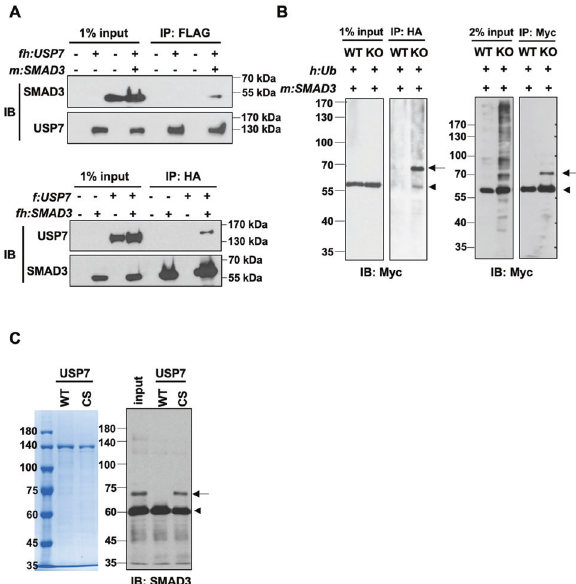
Fig. 6 USP7 interacts with SMAD3 and deubiquitinates the mono- ubiquitinated SMAD3. A Co-immunoprecipitation (co-IP) assays with anti-Flag (upper) or anti-HA (bottom) resins showing the interactions between USP7 and SMAD3 in HEK293T cells transfected with indicated expression constructs. fh Flag-HA, m Myc, f Flag. B Immunoprecipitation (IP) assays showing SMAD3 is mono- ubiquitinated in the absence of USP7. HEK293 wildtype (WT) or USP7 KO (KO) cells were co-transfected with expression vectors for HA-tagged ubiquitin (h:Ub) and Myc-tagged SMAD3 (m:SMAD3). IPs were performed with anti-Myc and anti-HA antibodies followed by immunoblotting with anti-Myc antibody. Arrow and arrowhead indicate mono-ubiquitinated and unmodi fi ed SMAD3, respectively. C Immunoblots of SMAD3 (right) in the reaction product of in vitro deubiquitinating assays showing the removal of mono-ubiquitin from SMAD3 by recombinant USP7 wildtype (WT) but not deubiquitinase-de fi cient CS mutant. Mono-ubiquitinated SMAD3 was isolated from transfected HEK293 cells as described in ( B ), recombinant USP7 proteins (left) were puri fi ed from baculovirus- infected insect